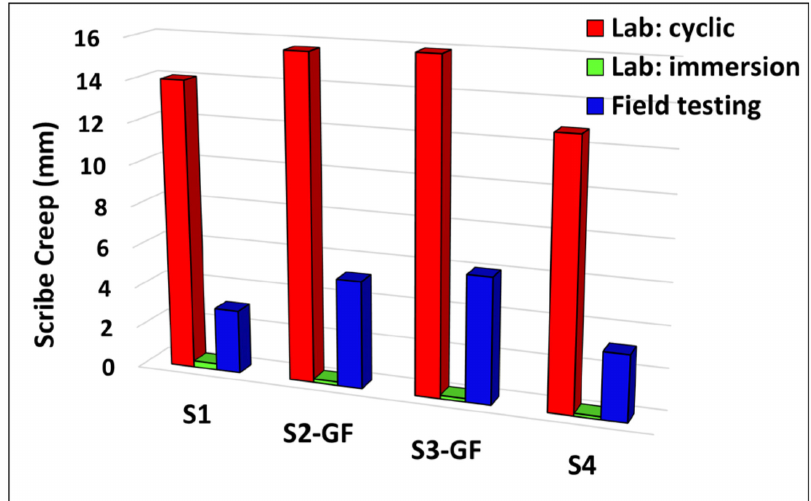
Figure 7. Scribe creep of the splash zone coating systems after accelerated aging and field testing. Table 9. Scribe creep in mm for the splash zone coating system before and after laboratory aging and field exposure.